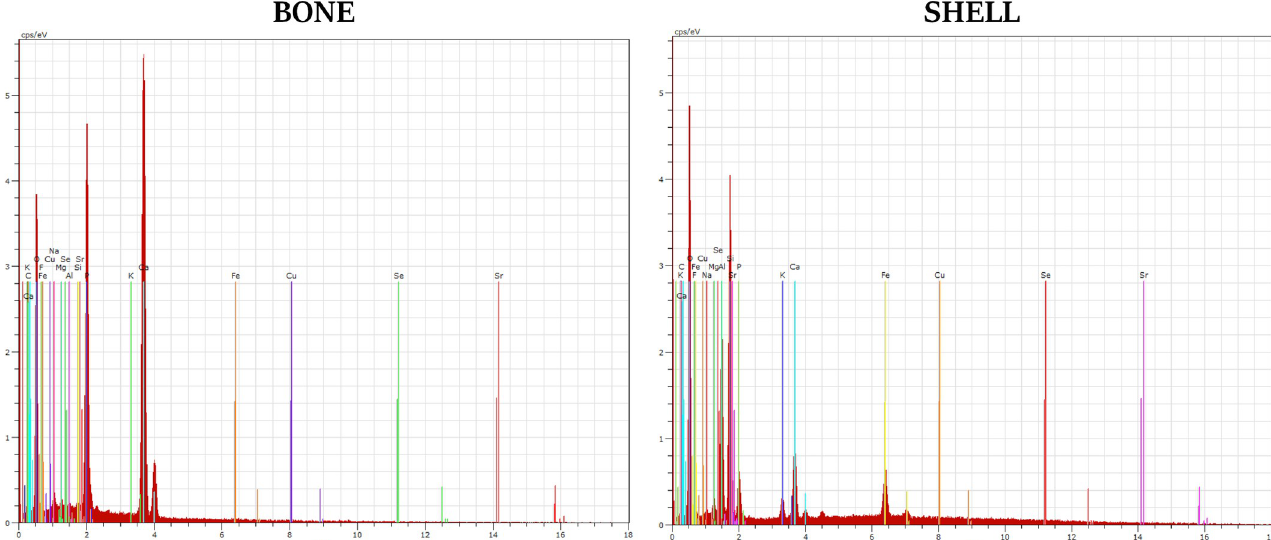
Fig 9. Percentage composition of the elements in bone and shell.